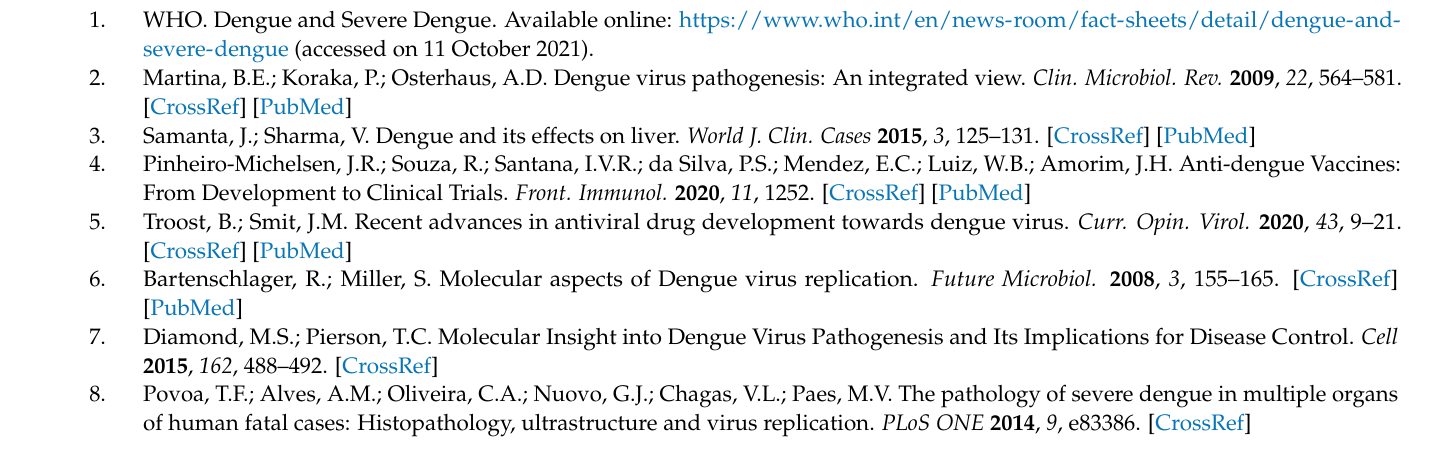
DBH mRNA levels, Figure S6: Effect of NE, as well VMAT and MAO inhibitors on DV replication, Figure S7: (A): Effect of the DV infection on the expression of OCT-1, (B) Reserpine increases the sensitivity of DV replication in 5-HTP, (C) Effect of catecholamine biosynthesis and metabolism pathway on HO-1 mRNA levels, (D) Reserpine diminishes the negative effect of H 2 O 2 on cell viability, Figure S8: DBH inhibition (nepicastat) has no effect on DV replication, Figure S9: Effect of DV genome translation and replication on DDC mRNA levels, Figure S10: Effect of DA and reserpine on the levels of p-Akt